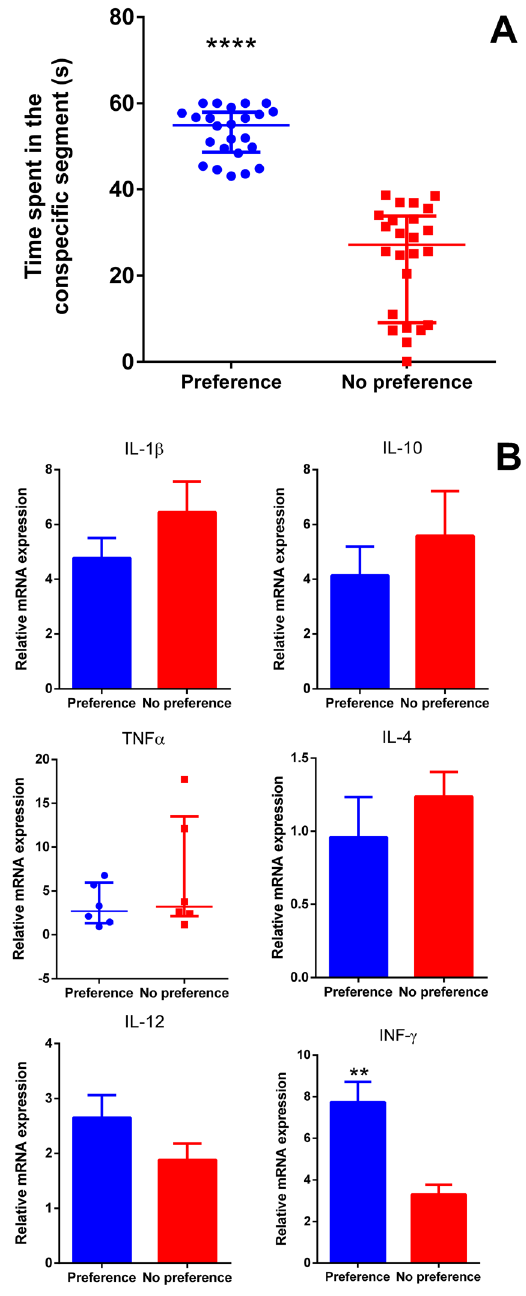
Figure 2. Social preference test- time spent in the conspecific segment. ( A ), and gene expression of cytokines ( B ). Each data represents the mean ± SEM or median ± interquartile range, depending on the data normality assessed by the Bartlett’s test. In panel A data represents the median of 24 fish and in panel B data represents the mean or median of 6 pooled samples. Significant differences are represented by asterisk ( ** p < 0.01; **** p <